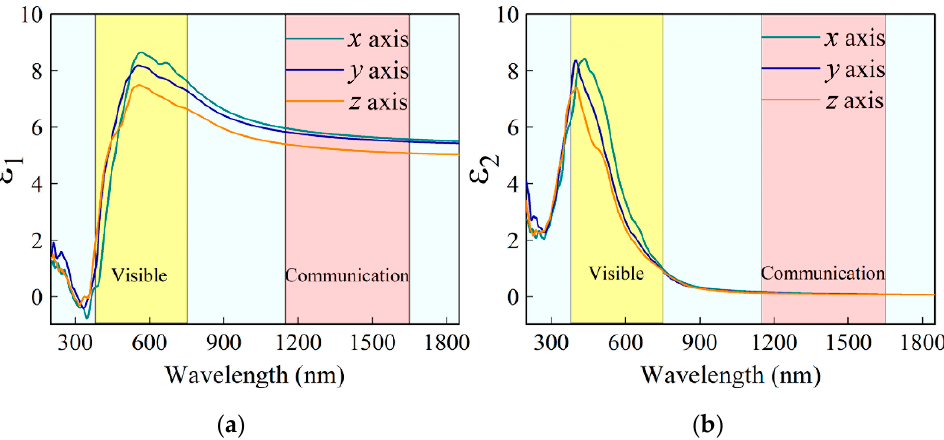
Figure 2. ( a ) Real part ε 1 and ( b ) imaginary part ε 2 of dielectric function of (CH 3 NH 3 )PbI 3 based on the first-principles calculation.